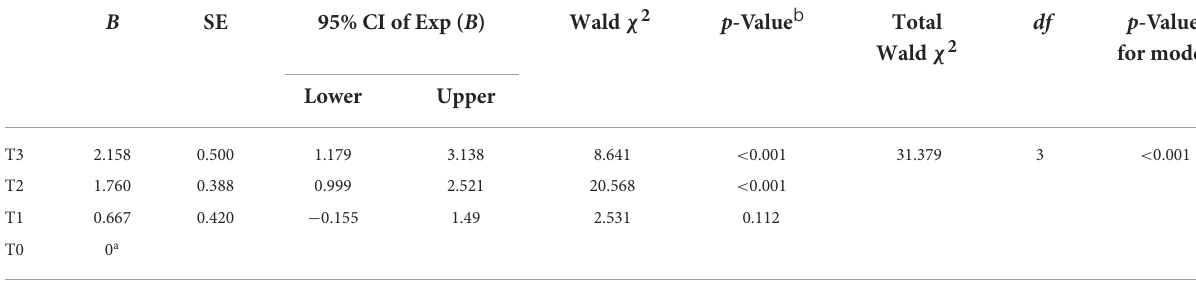
TABLE 3 Results of generalized estimating equation of the family resilience ( N =